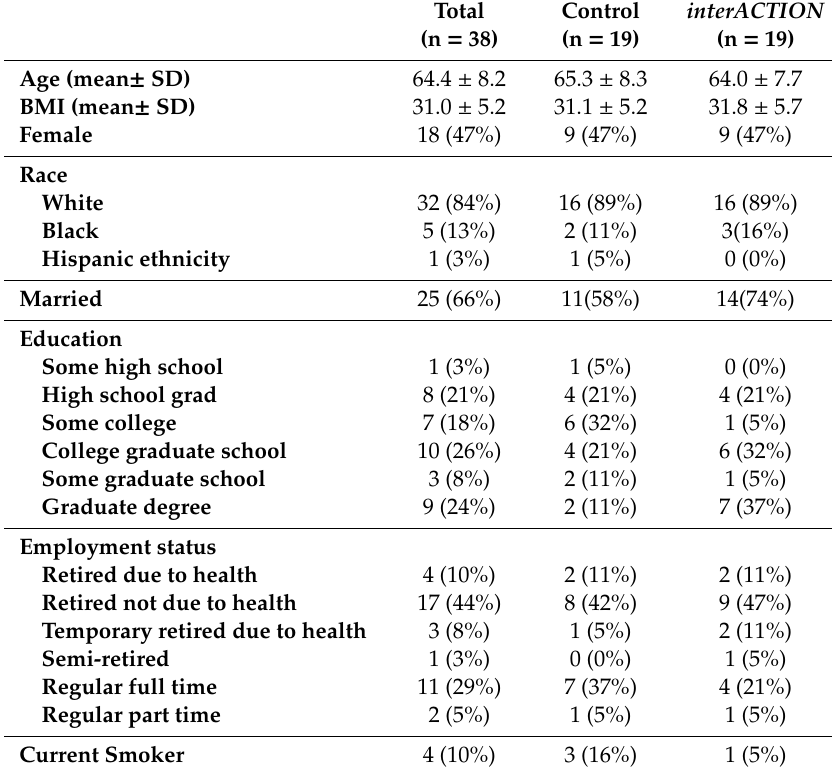
Figure 2. Consolidated standards of reporting trials (CONSORT) diagram of participant flow during the study. Table 1. Participant characteristics at